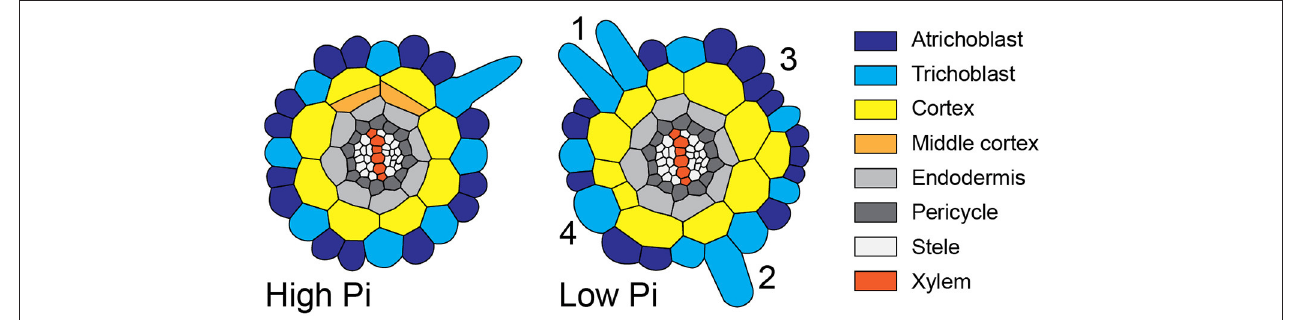
FIGURE 8 | Schematic diagram showing atypical root hair patterning scenarios found under low Pi conditions. Schematic representations of root radial cross sections under high Pi (Left) and low Pi (Right) conditions showing changes in tissue patterning including four atypical root hair patterning scenarios. These scenarios are: (1) the formation of 2 adjacent hair cells files forming over two adjacent cortical cells clefts, (2) the formation of a hair cell in a non-hair-cell position, (3) no root hairs forming from an H-cell file, and (4) one H cell file forming over two adjacent cortical cell clefts.